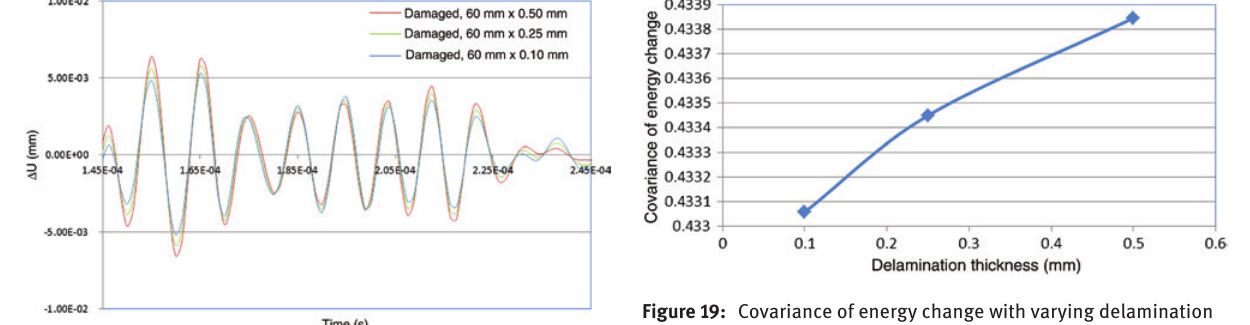
Figure 19: Covariance of energy change with varying delamination thickness size at Section 2.